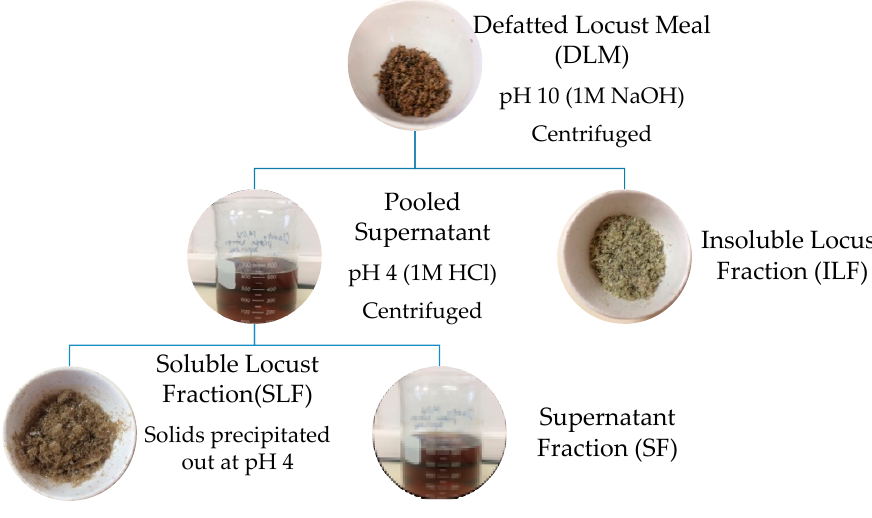
Figure 1. A schematic representation of the methodology used to extract L. migratoria protein fractions.